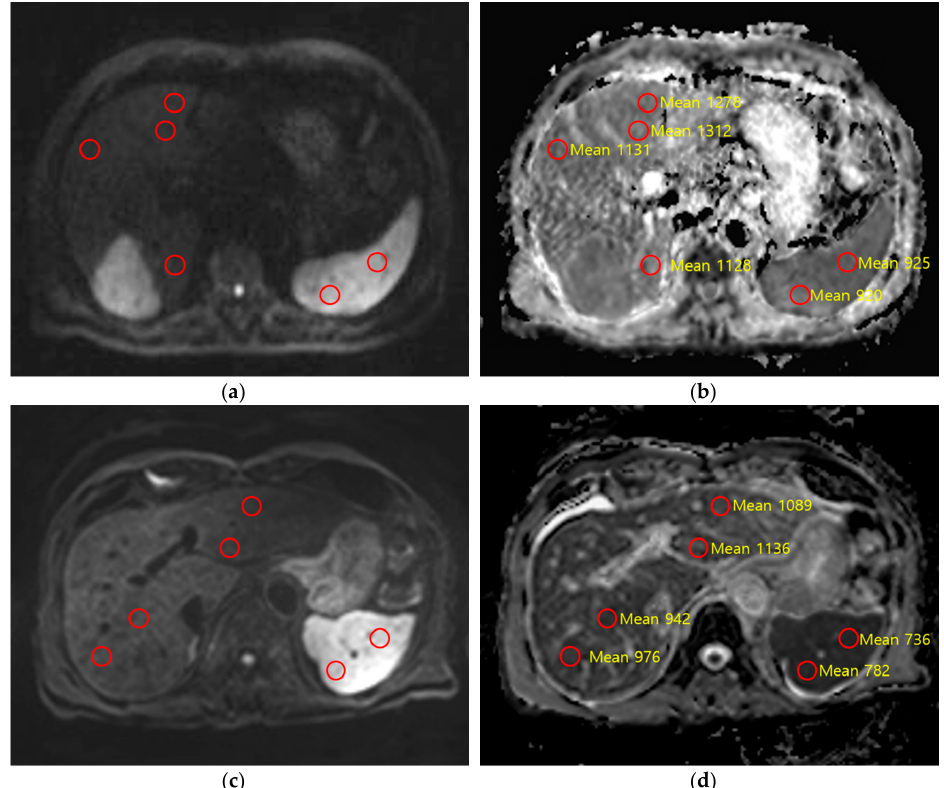
Figure 4. Two patients who underwent surgical resection for hepatocellular carcinoma (HCC) and pathologically confirmed cirrhosis (F4). Red circle indicates region of interest for ADC value Red circle indicates region of interest for